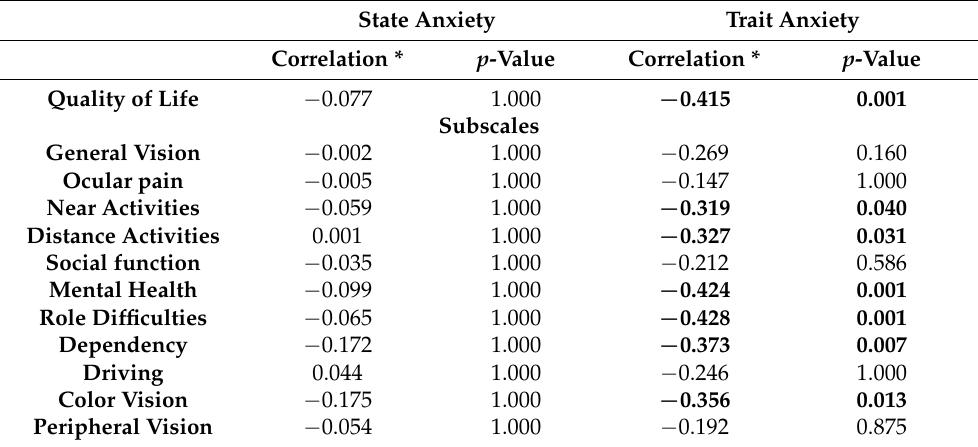
Table 2. Correlation between state and trait anxiety and the VFQ-25 quality-of-life questionnaire and its subscales.